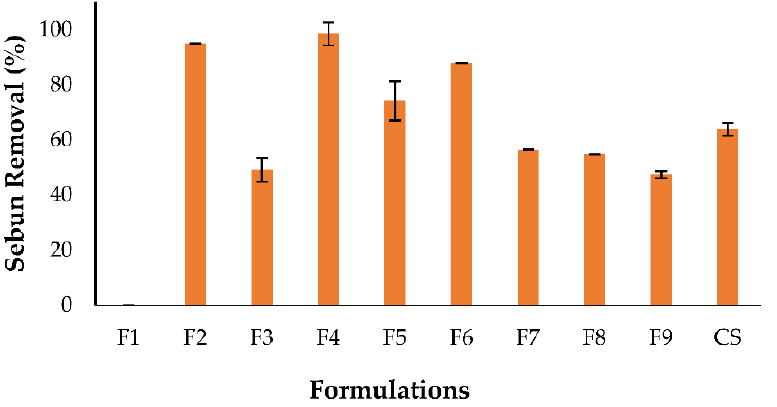
Figure 13. Cleaning potential of formulations: F1: no surfactant; F2: DCG; F3: DCG + C. quinoa; F4: DCG + G. max; F5: DCG + M. emarginata; F6: DCG + C. quinoa + G. max; F7: DCG + C. quinoa + M.